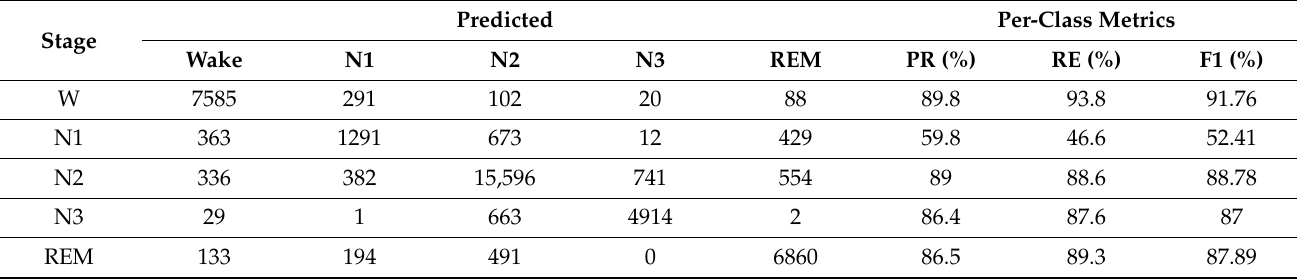
Table 4. Confusion matrix of Sleep-EDFX-20 dataset.